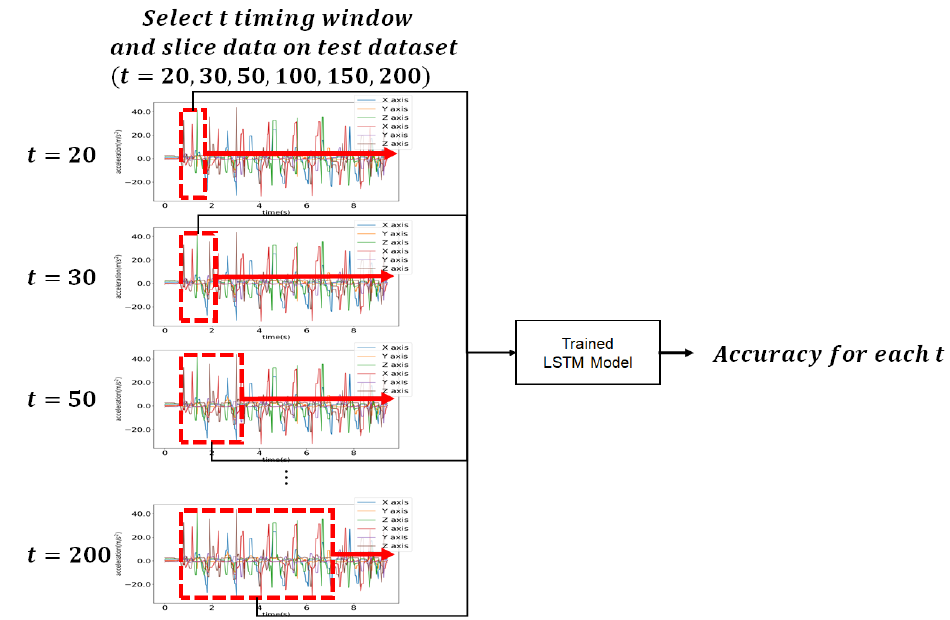
Figure 11. Test data selection for performance evaluation. Table 1. User identification rate regarding timing window